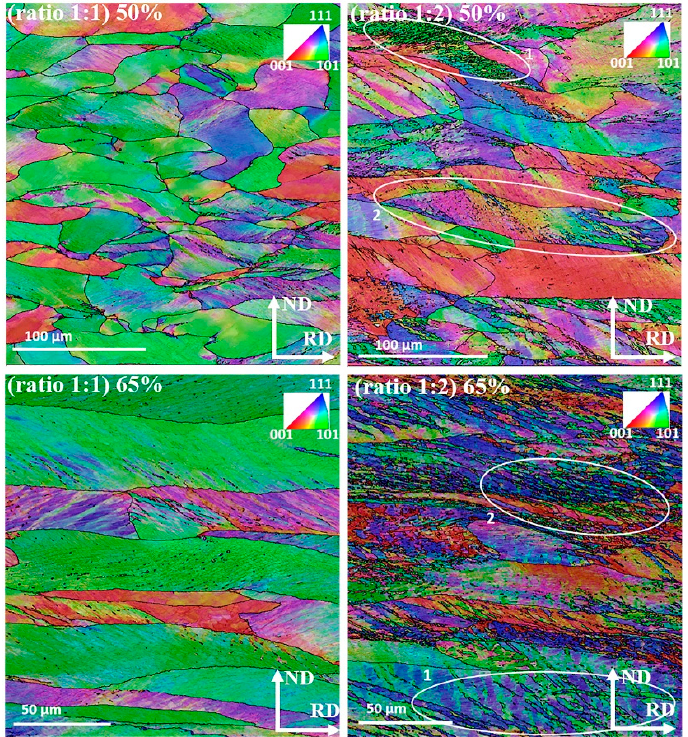
Figure 7. IPF maps taken on the TD surface (by projecting the RD axis), in the mid thickness area, for asymmetry ratios of 1:1 and 1:2 with TRPPs of 50% and 65%.